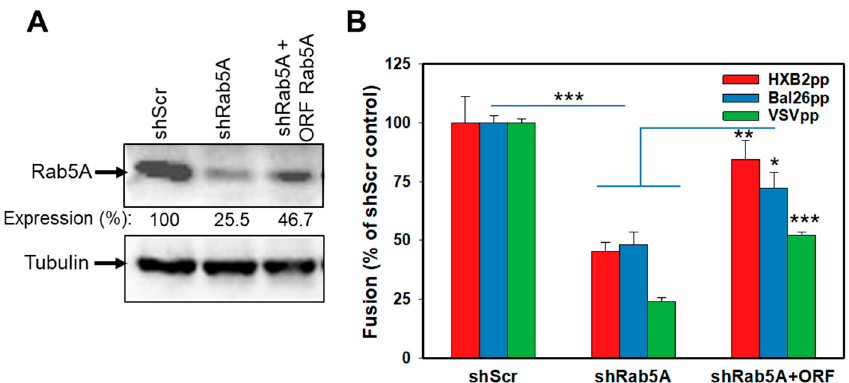
Figure 3. Partial rescue of HIV-1 and VSV fusion with shRNA-transduced cells upon ectopic expression of Rab5A. CEM.CCR5 cells transduced with Rab5A shRNA were transduced with a vector expressing shRNA-resistant Rab5A construct. ( A ) Western blot analysis of Rab5A expression. Rab5A expression levels relative to control cells determined by densitometry analysis are shown below the top image panel. ( B ) HXB2pp, BaL26pp and VSVpp fusion activity, as measured by the BlaM assay, is enhanced upon expression of Rab5A in Rab5A-depleted cells. The data points are means and SEM from two independent triplicate experiments. *, P < 0.05; **, P < 0.01; ***, P <